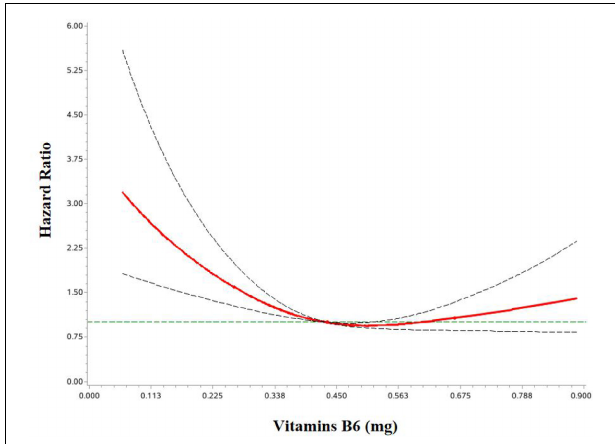
FIGURE 2 | HR and 95%CIs of overall survival among OC patients by vitamin B6. The association was adjusted for age at diagnosis, body mass index, total energy, alcohol drinking, diet change, education, income, physical activity, menopausal status, parity, multivitamin use, multimineral use, red meat, methyl-donor index, comorbidities, FIGO stage, histological type, histopathologic grade, and residual